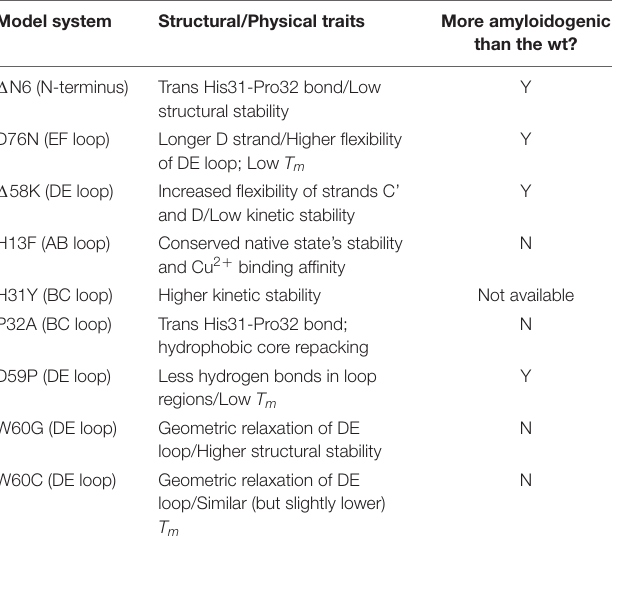
TABLE 1 | Model systems used in the study of β 2m aggregation together with its physical and structural properties. Model